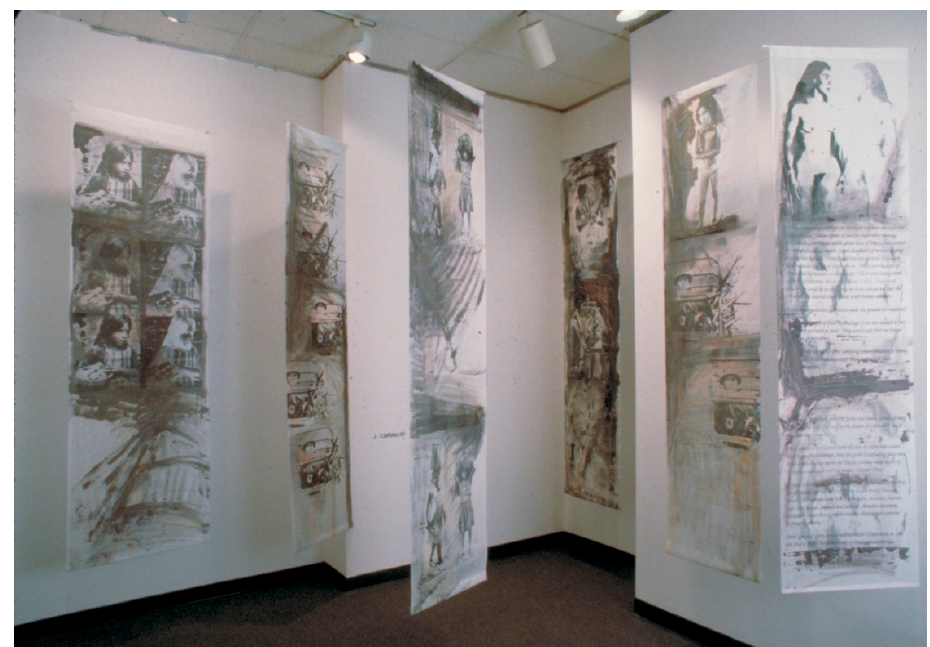
Figure 13. Josely Carvalho, Craters of Blood , 1984, 6 panels of various sizes, silkscreen, crayon, and dyes on silk. Courtesy of the artist.